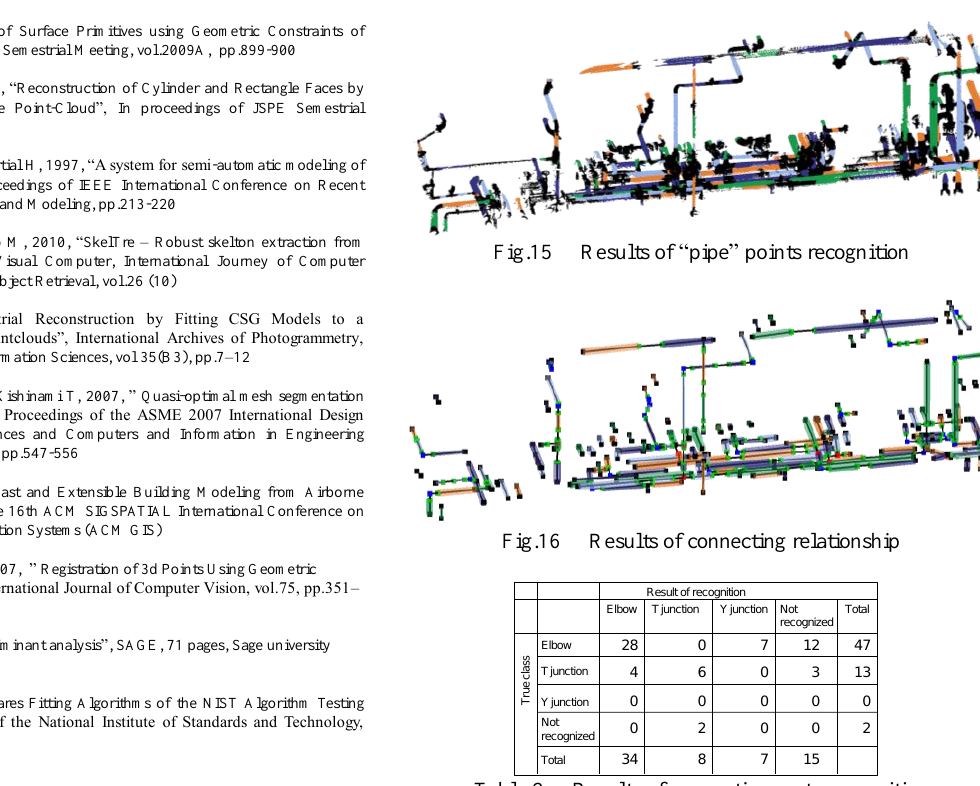
Fig.14 Scanned data of an oil rig